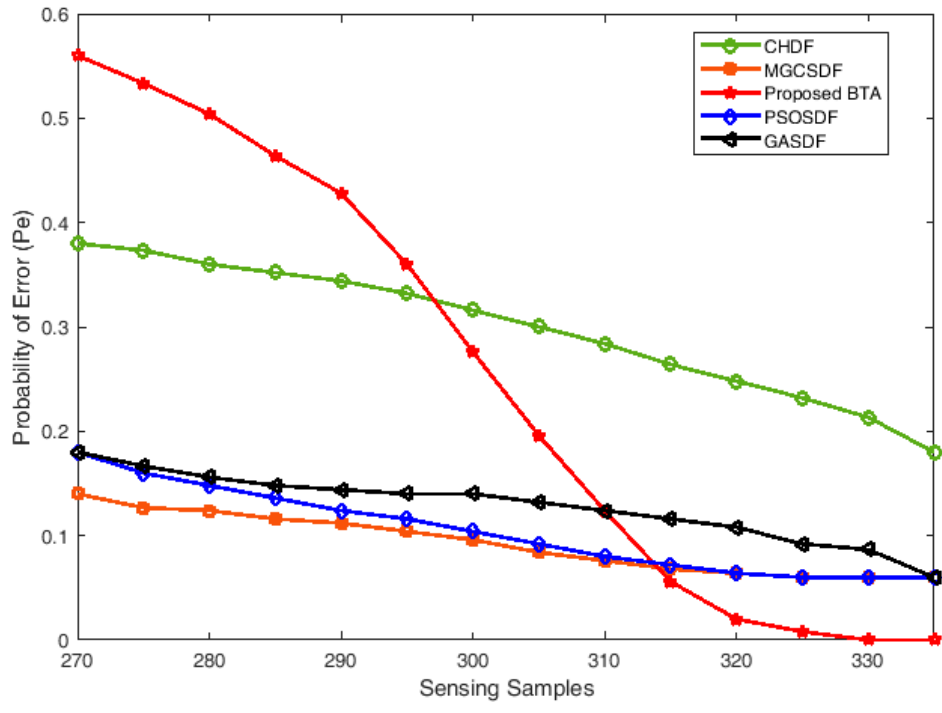
Figure 6. Probability of error vs. sensing samples under normal users.